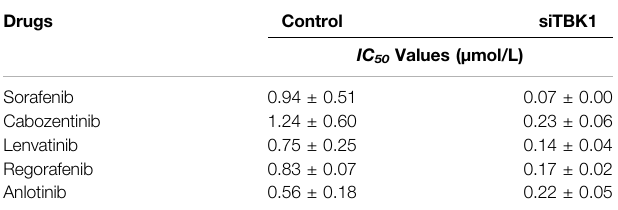
TABLE 6| Theeffect ofTBK1 knockdown onthesensitivity ofMHCC97-H cellsto molecular-target drugs, Sorafenib, Cabozentinib, Lenvatinib, Regorafenib or